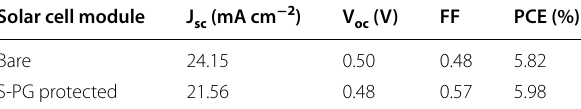
Table 1 Photovoltaic characteristics of the solar cell module covered with and without fabricated siloxane functionalized GO incorporated PUA composite (S-PG) superhydrophobic film with µ-pillar distance of 70 μm Solar cell module S‑PG